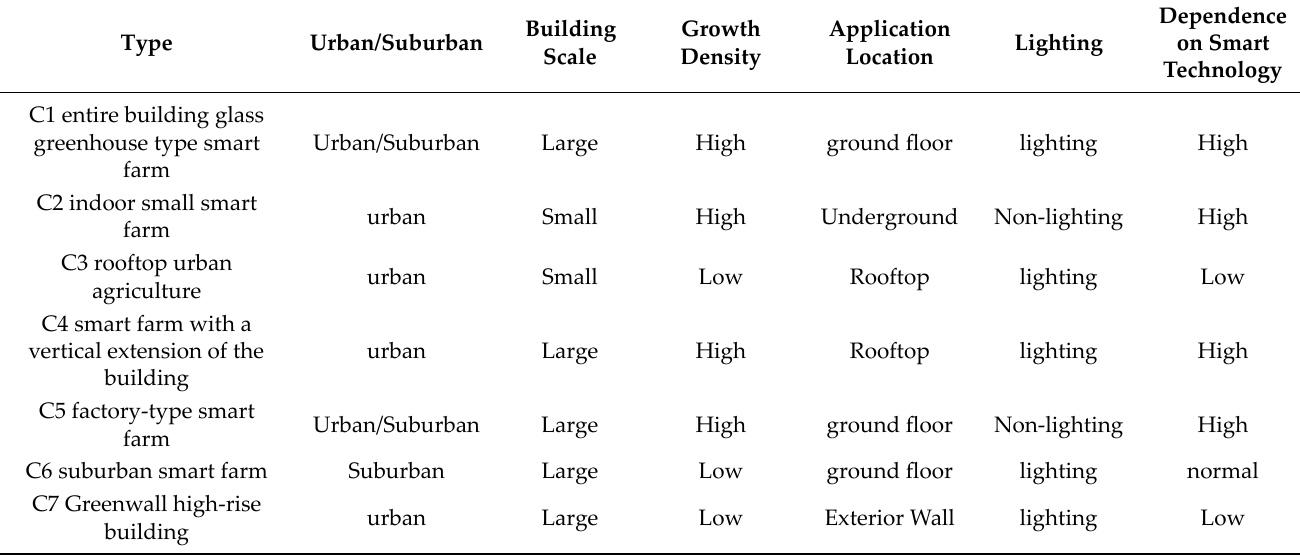
Table 2. Characteristics of the 7 types of smart